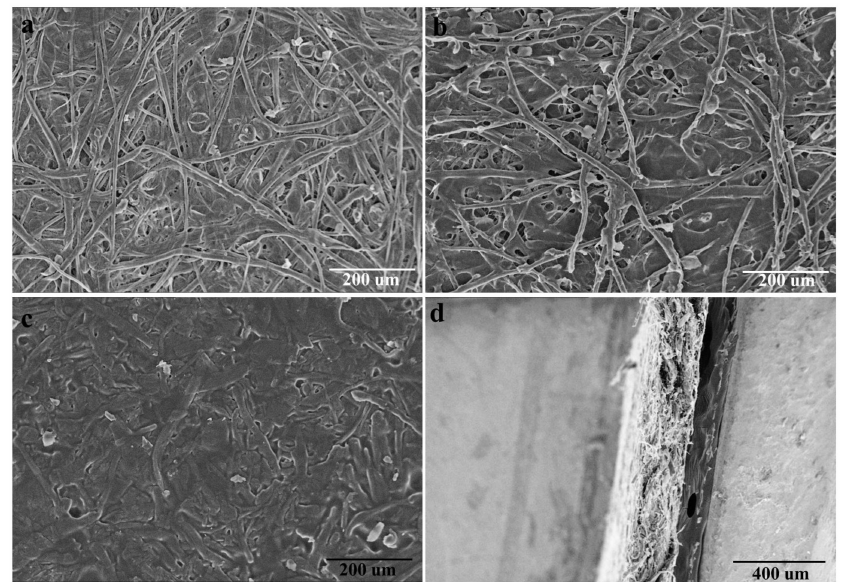
Figure 7. ( a , b ) The SEM images of waste disposable paper cups (WDPC) inner surface before and after peeling off the thin PE coating; ( c , d ) SEM images (( c ), the surface and ( d ), the cross section) of the paper plastic composites